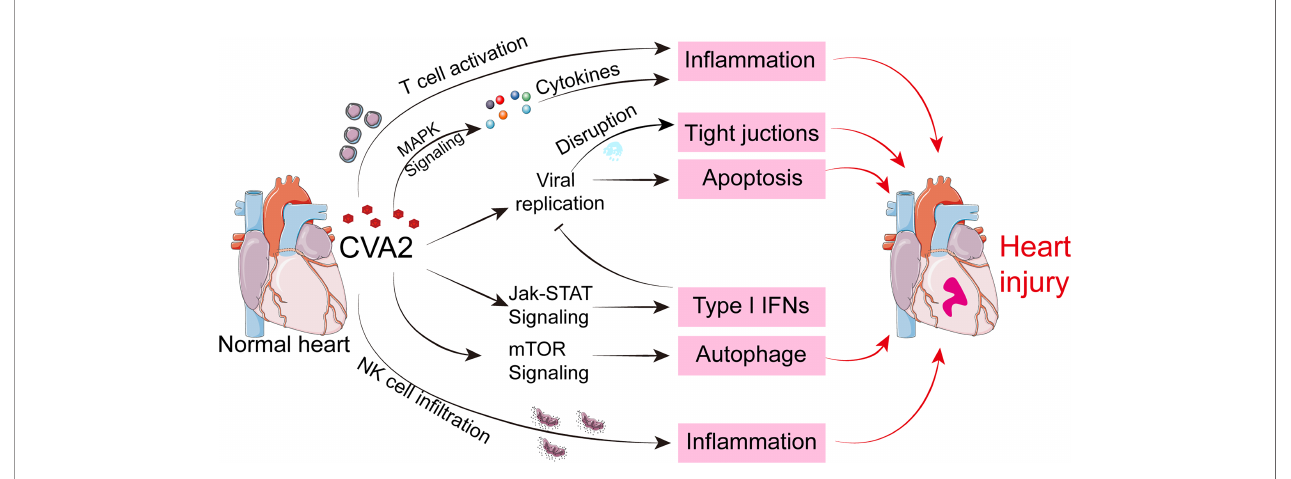
FIGURE 10 | A hypothetical schematic of the mechanisms of heart injury caused